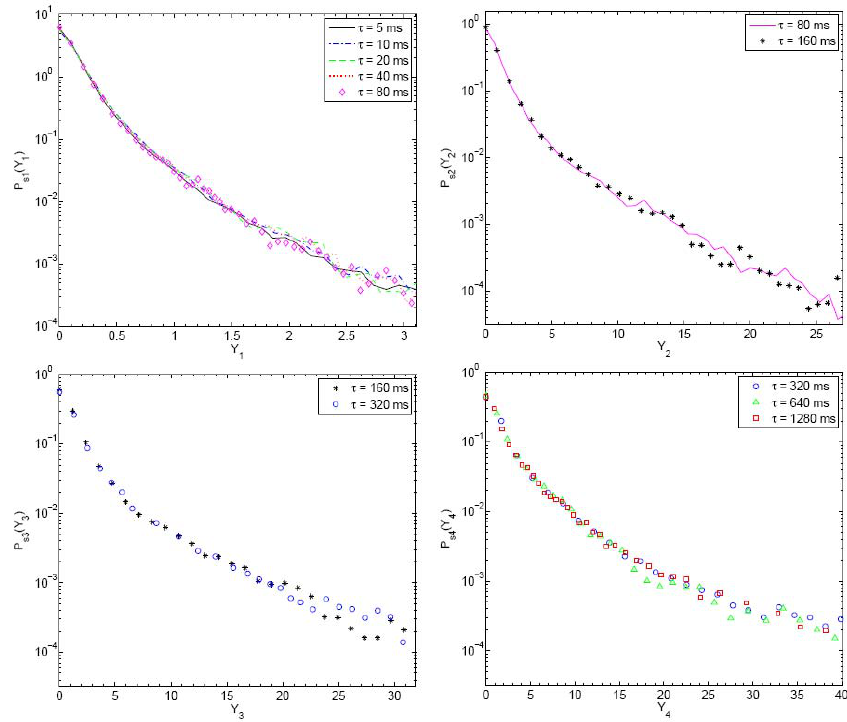
Fig. 7. Scaling function P si (Y i ) obtained from the PDF at each time scale of Regime i , where i = 1, 2, 3 and